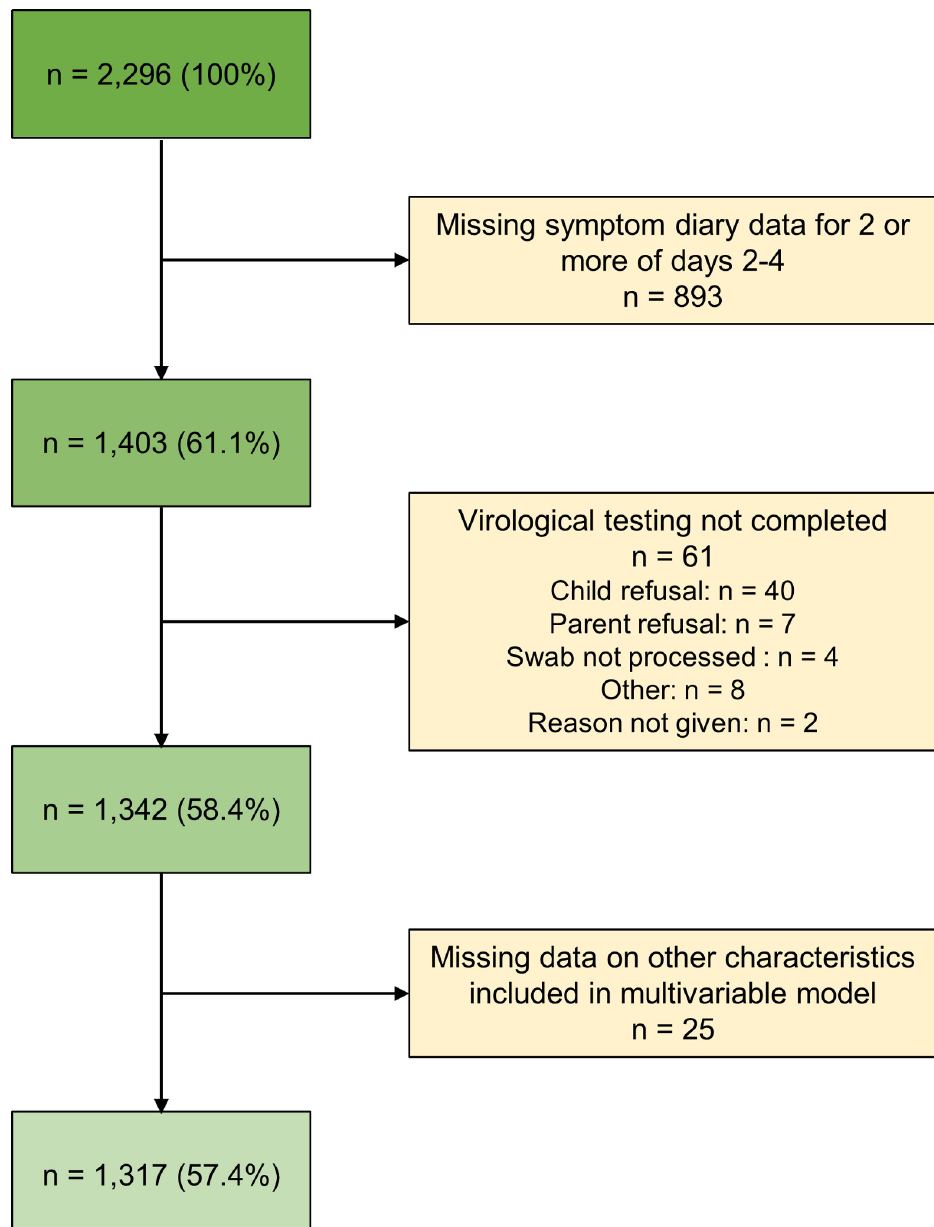
Fig 1. Flow chart of participants through the